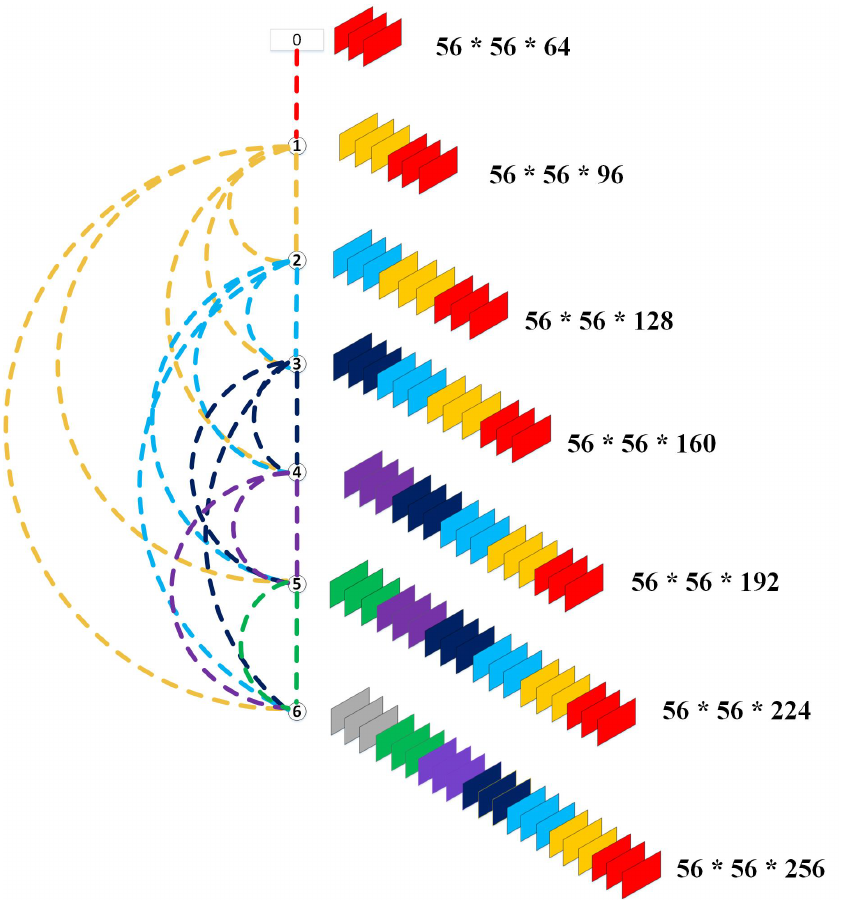
Figure 3. Illustration of feature map concatenation in each